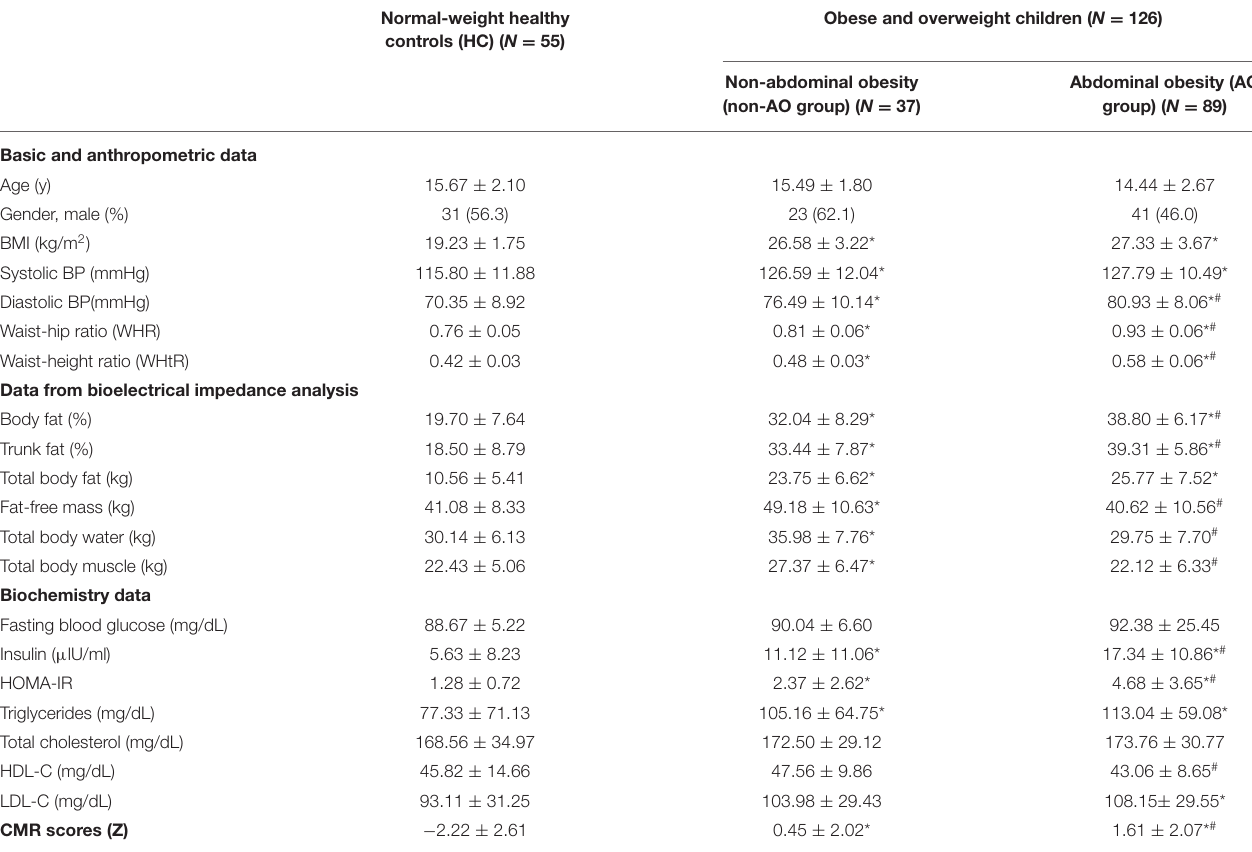
TABLE 1 | Anthropometric and biochemical characteristics of the study participants.